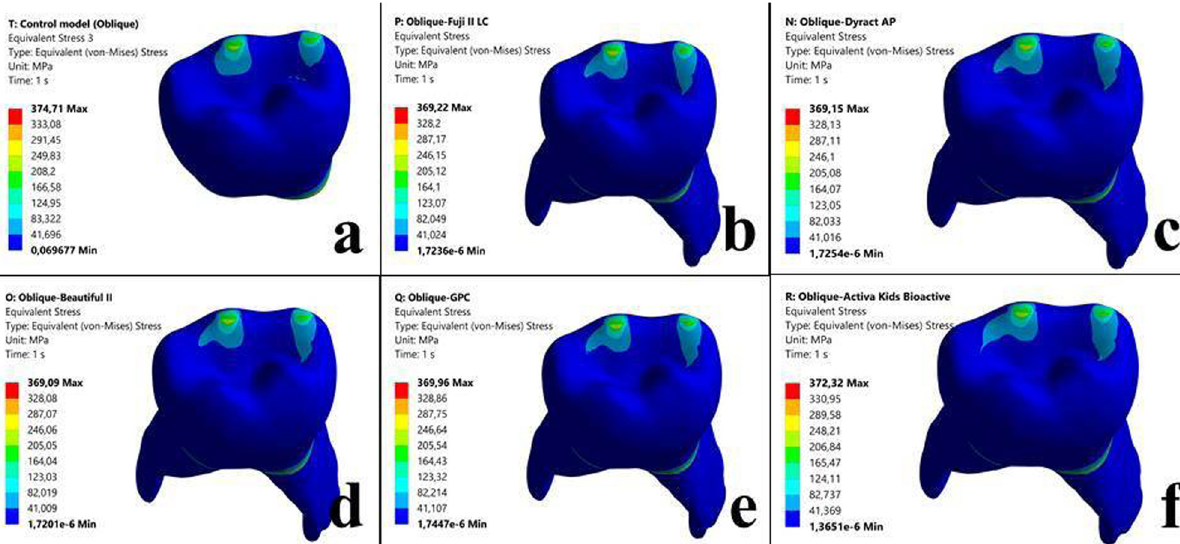
Figure 3: Distribution of Von Mises stress for models with oblique loading: ( a ) tooth model without restoration ( control group ) , ( b ) tooth model with Class I restoration ( resin - modi fi ed glass ionomer ) , ( c ) tooth model with Class I restoration ( compomer ) , ( d ) tooth model with Class I restoration ( giomer ) , ( e ) tooth model with Class I restoration ( glass carbomer ) and ( f ) tooth model with Class I restoration ( ionic resin material with bioactive properties )